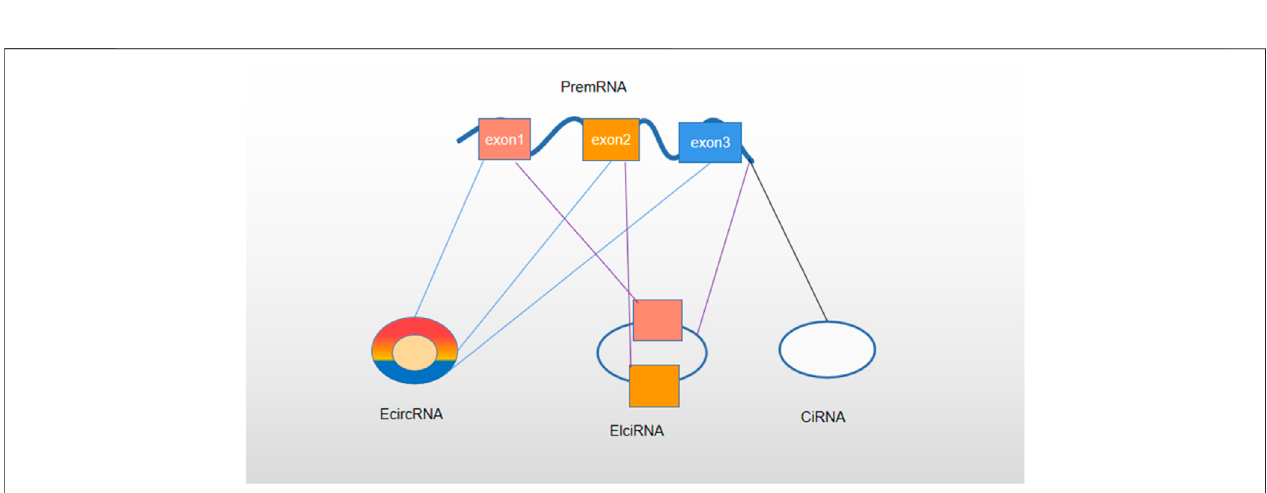
FIGURE 2 | Classi fi cation of circRNA. Based on the composition, circRNAs are classi fi ed as exonic circRNAs (ecircRNAs), circular intron circRNAs (ciRNAs), and exon – intron circRNAs (EIciRNAs).